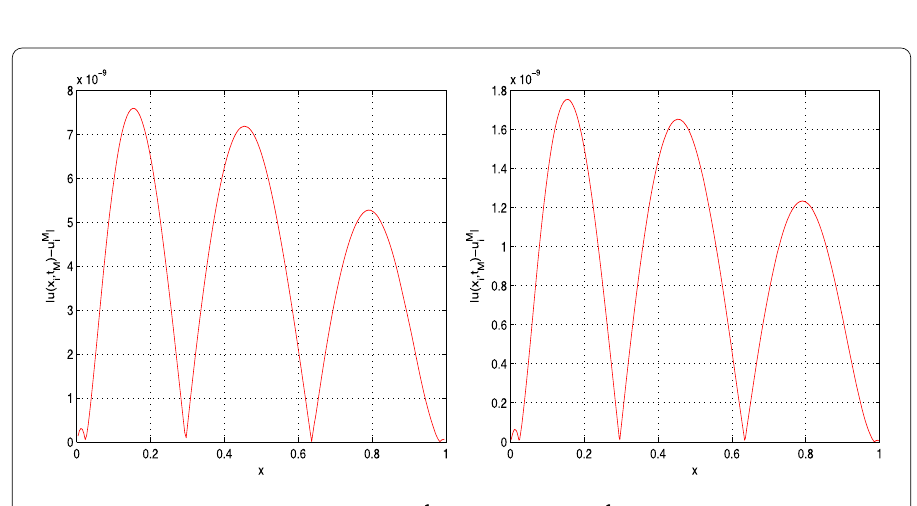
(left) and h = τ = 1 (right) at t M = 1 when α = 1.8, 256 512